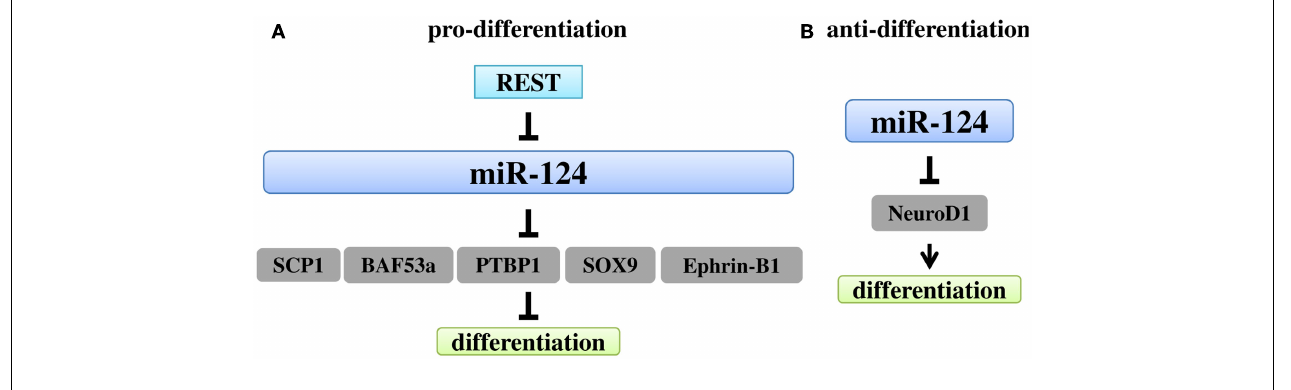
differentiation, targeting SCP1, BAF53a, SOX9, PTBP1, and Ephrin-B1, respectively. (B) MiR-124 can also inhibit NSC differentiation by targeting NeuroD1, a pro-neuronal